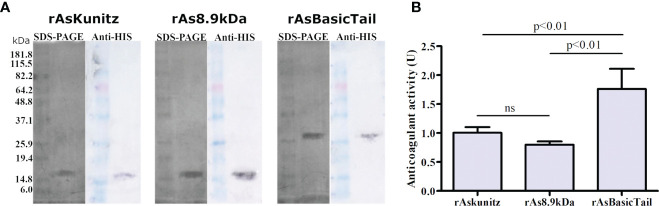
Expression of rAsKunitz, rAs8.9kDa, and rAsBasicTail and their effect on the coagulation cascade. Sodium dodecyl sulfate polyacrylamide gel electrophoresis (SDS-PAGE) (silver staining) and western blotting (developed using anti-His-tag antibodies) of each recombinant protein (A). Effect of 0.25 µM of each recombinant on the human coagulation cascade (B). One unit (U) of anticoagulant activity indicates that the coagulation time was doubled. Statistical analysis: ANOVA–Tukey, ns = not significant (p>0.05). Data is shown as mean ± SD.